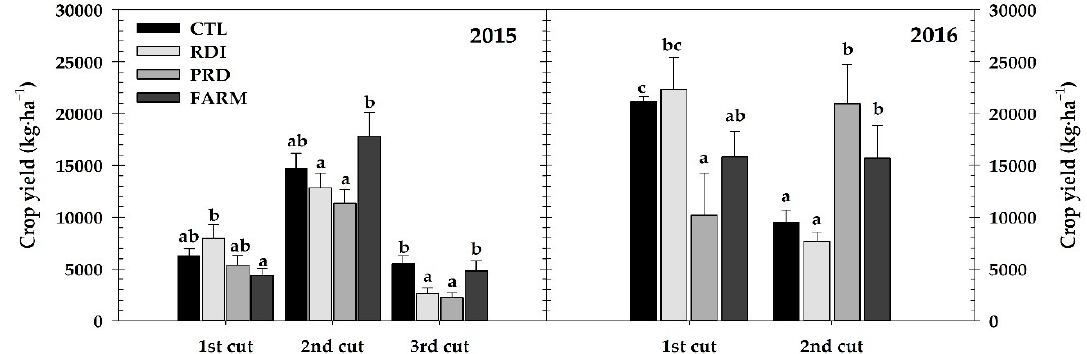
Figure 6. Crop yield (kg · ha − 1 ) evaluated at each harvest during the harvest period (from September to November) in all irrigation treatments (Control, RDI, PRD, and Farm) during the first two years (2015 and 2016). Bars are the means ± SE ( n = 3). Vertical bars indicate the standard error. Columns with different letters denote significant differences according to Duncan’s multiple range test ( p < 0.05).